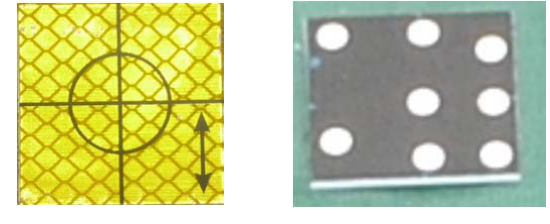
Figure 14: Retro-Reflective Targets